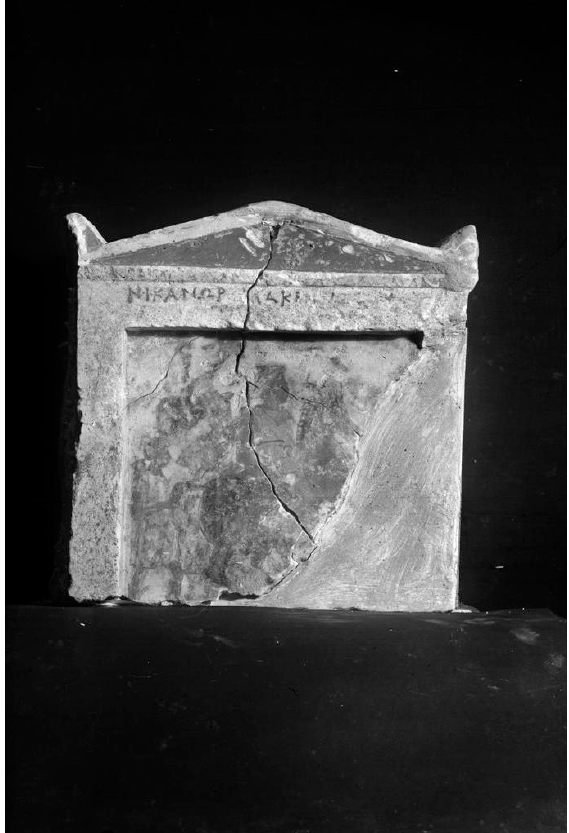
Figure 7. Funerary Stela of Nikanor, a Macedonian. Photograph courtesy of Kyriakos Savvopoulos.